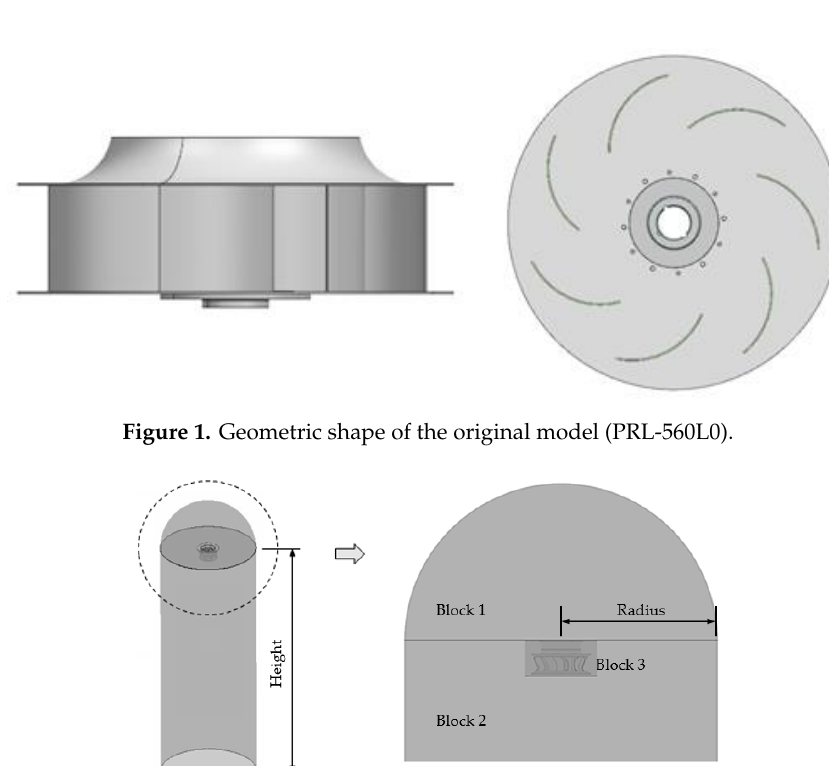
Figure 1. Geometric shape of the original model (PRL-560L0). Table 1. Rated variables of the plenum fan.